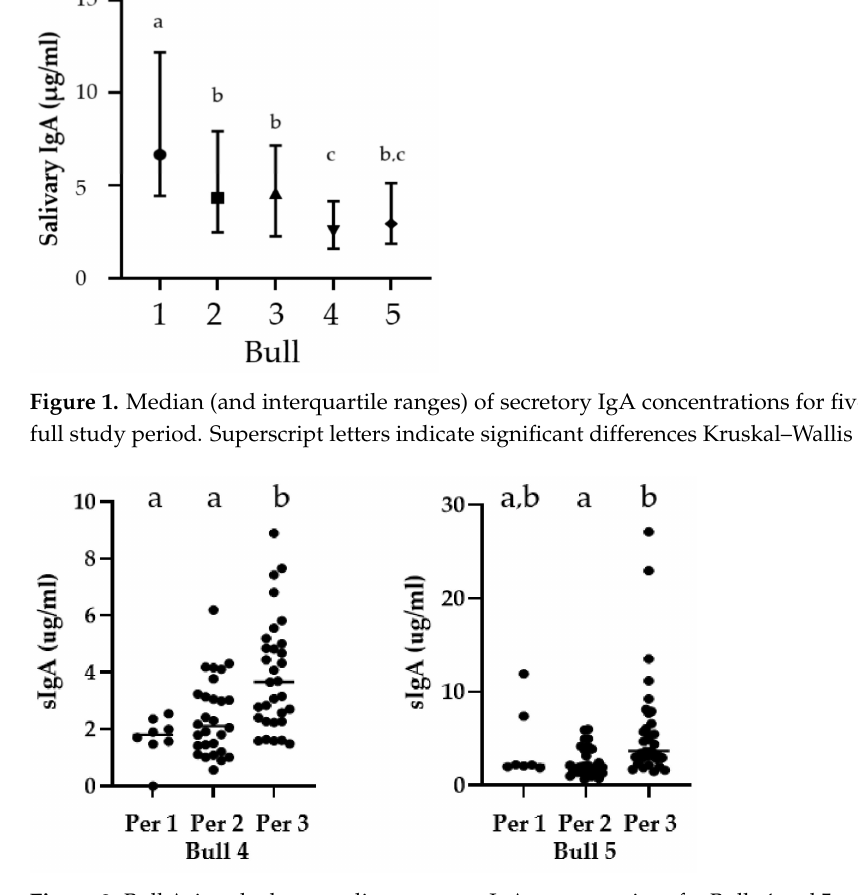
Figure 2. Bull Asian elephant median secretory IgA concentrations for Bulls 4 and 5 over three periods (before, during and after introductions). Different superscripts ( a , b ) indicate statistically significant differences ( p < 0.05). Note the difference in y-axis